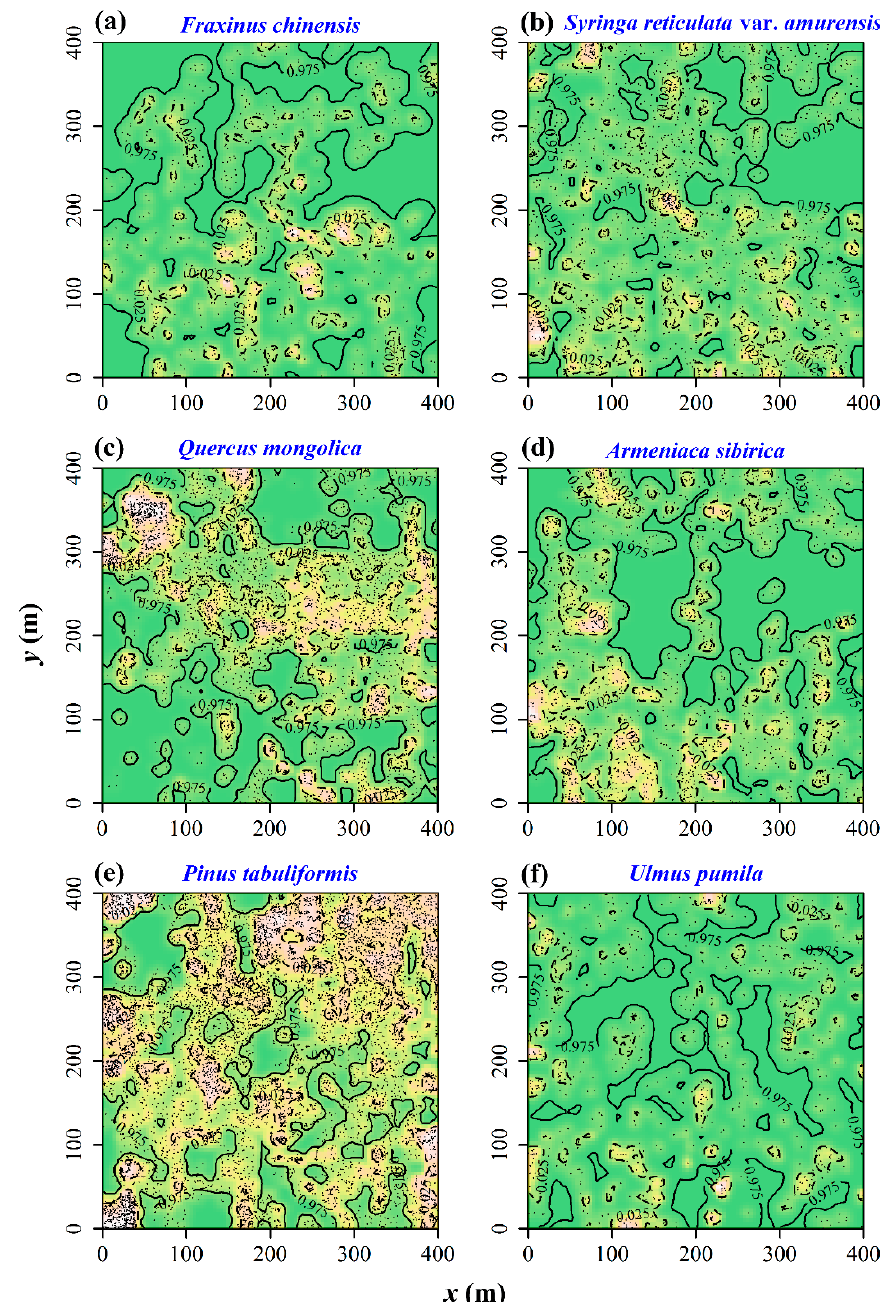
Figure 4. The p -value surfaces for six dominant tree species based on 399 Monte Carlo simulations. In each panel, the brighter the color is, the higher the p -value is. There are two isolines: 0.025 and 0.975. The areas with the p -value less than 0.025 have greater relative intensities than the average level, and the areas with the p -value greater than 0.975 have lower relative intensities than the average level. ( a ) F. chinensis ; ( b ) S. reticulata var. amurensis ; ( c ) Q. mongolica ; ( d ) A. sibirica ; ( e ) P. tabuliformis ; ( f ) U. pumila .